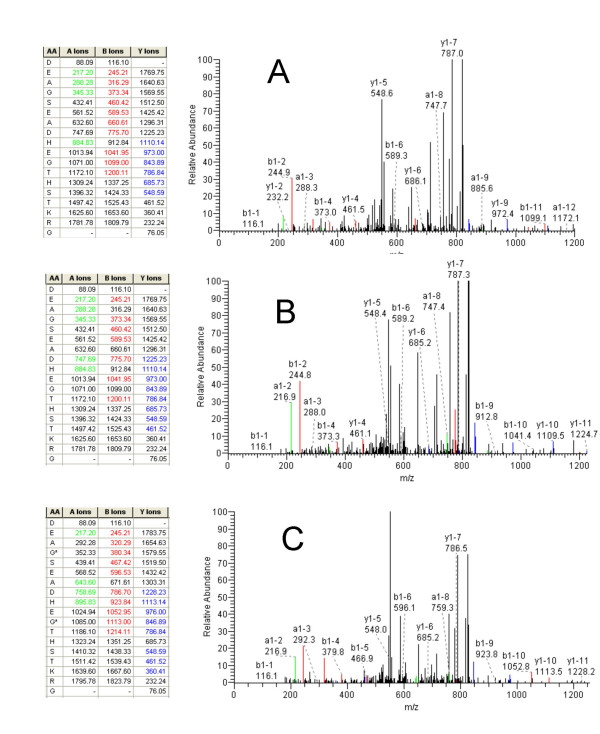
Fibrinogen peptide MS/MS data. Figure 7a shows one of the MS/MS spectra used to identify the m/z 1885 SELDI peak as the fragment of fibrinogen DEAGSEADHEGTHSTKRG (3+ parent ion, 1+ fragments). Figure 7b shows MS/MS analysis of synthetic DEAGSEADHEGTHSTKRG. Figure 7c shows MS/MS analysis of synthetic DEAGSEADHEGTHSTKRG with 13C + 15N labelled alanine at positions 3 and 7 and glycine at positions 4 and 11. All spectra obtained by LC-MS/MS as described in the Methods section.